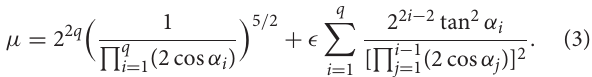
FIGURE 2 | Planar D-Bar (Complexity q the length of the strings at level q . l b represents bar